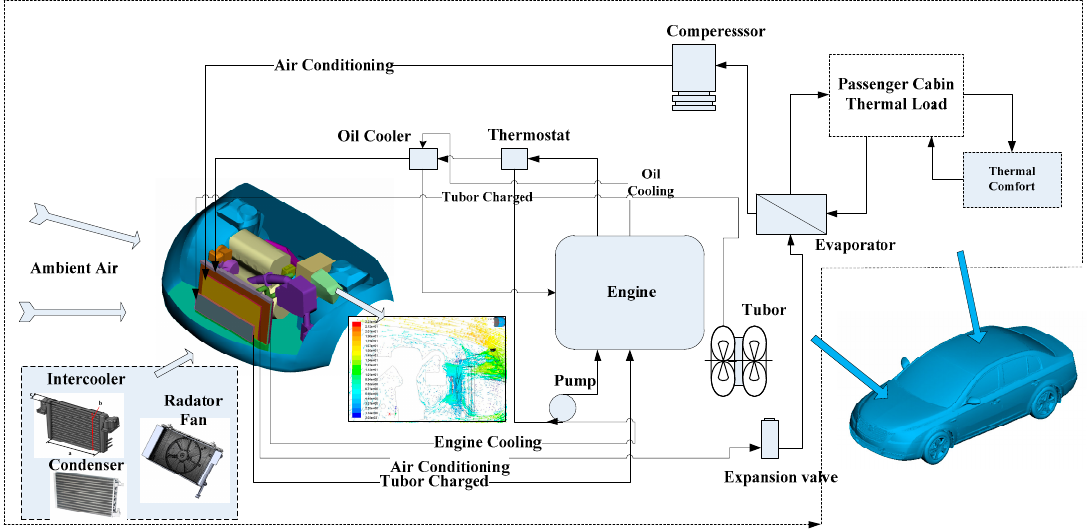
Figure 11. VITM of underhood cooling and air conditioning.